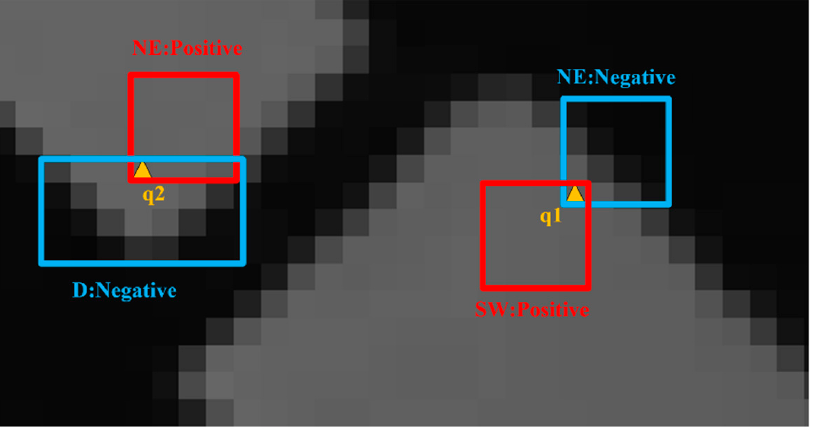
Figure 11. SWF clustering visualization. SW is the positive class of q 1, NE is the negative class of q 1, NE is the positive class of q 2, and D is the negative class of q 2. NE is the positive class of q 2, and D is the negative class of q